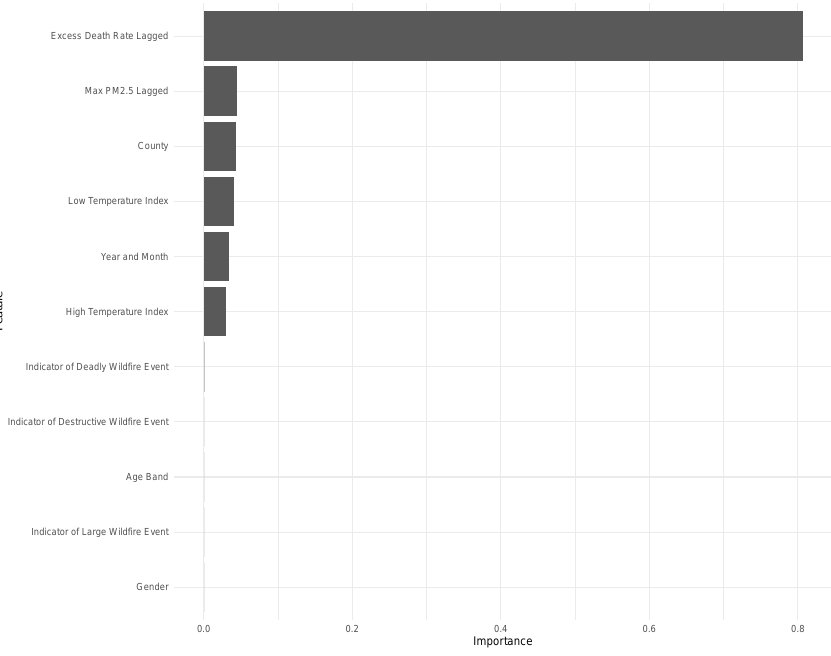
Figure 7. Feature Importance from XGB